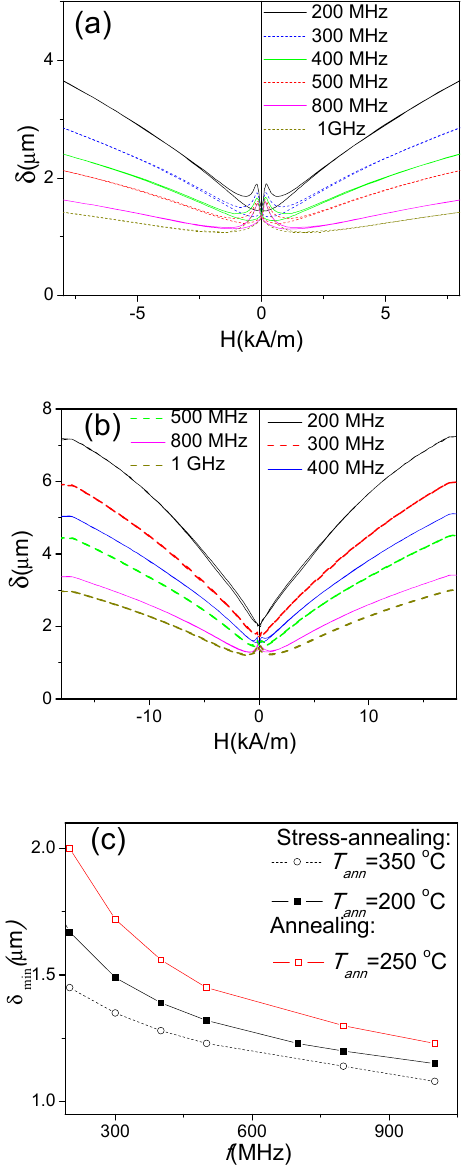
Figure 10. Calculated δ (H) dependencies for stress-annealed at T ann = 350 °C sample ( a ) for the sample annealed (without stress) at T ann = 250 °C ( b ) and δ min (f) dependencies estimated for stress-annealed at T ann = 350 °C and T ann = 200 °C samples ( c ).